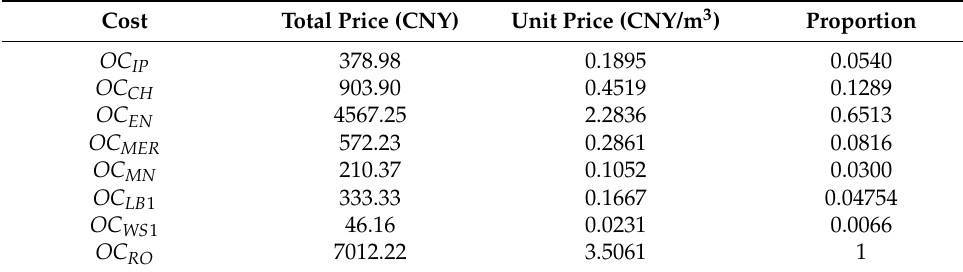
Table 8. SWRO system cost ratio table.